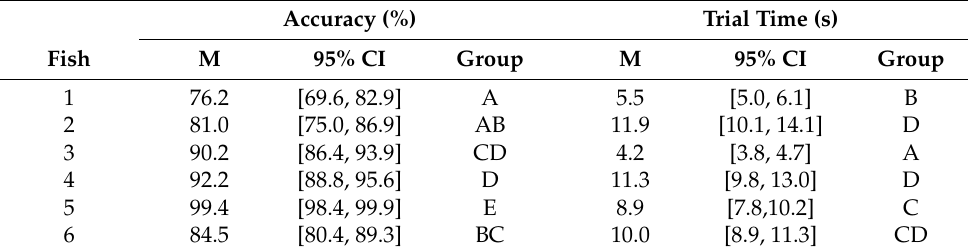
Table 4. Accuracy and trial time in testing for all